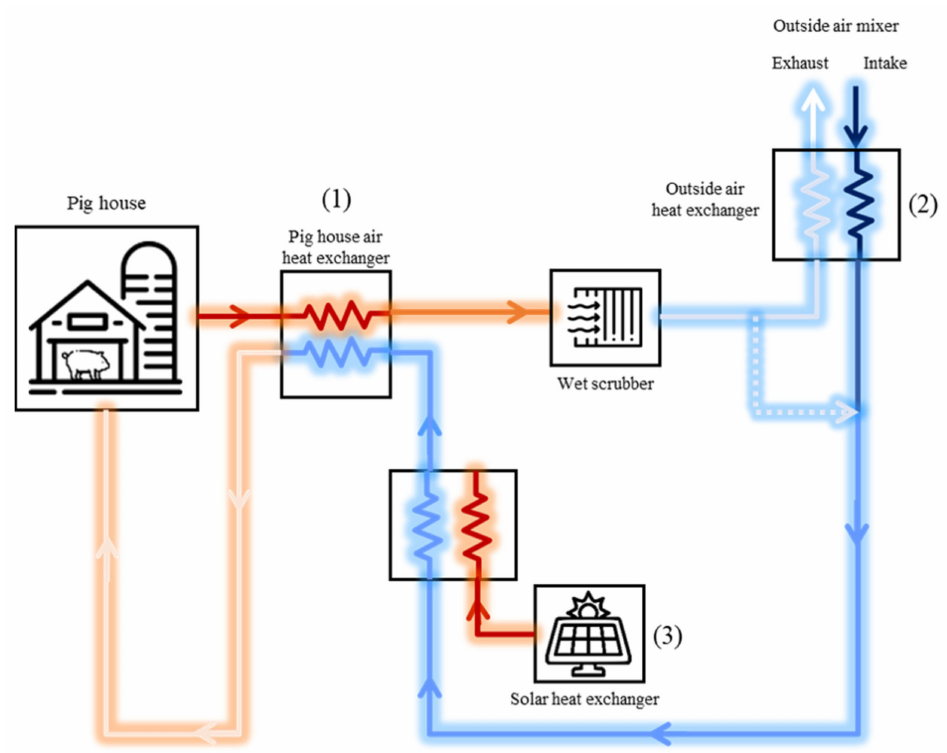
Figure 5. Schematic diagram of the air recirculated ventilation system. (1) Heat exchanger can reuse the internal heat of pig house according to the exchange efficiency. (2) it can reuse the heat after wet scrubber. (3) Solar heat exchanger was additional heating device to use solar